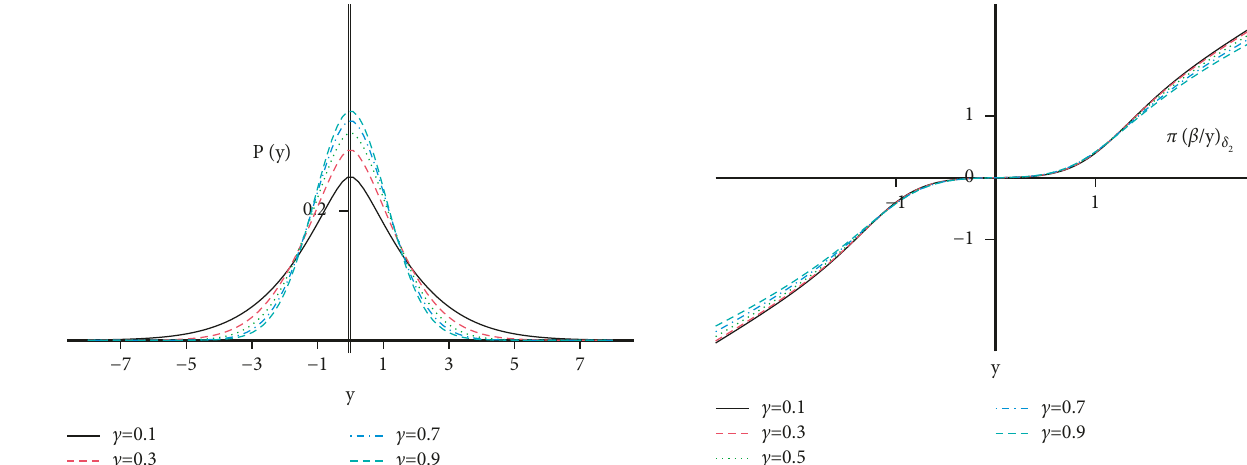
| y ) of β with different values of c � i i δ 2